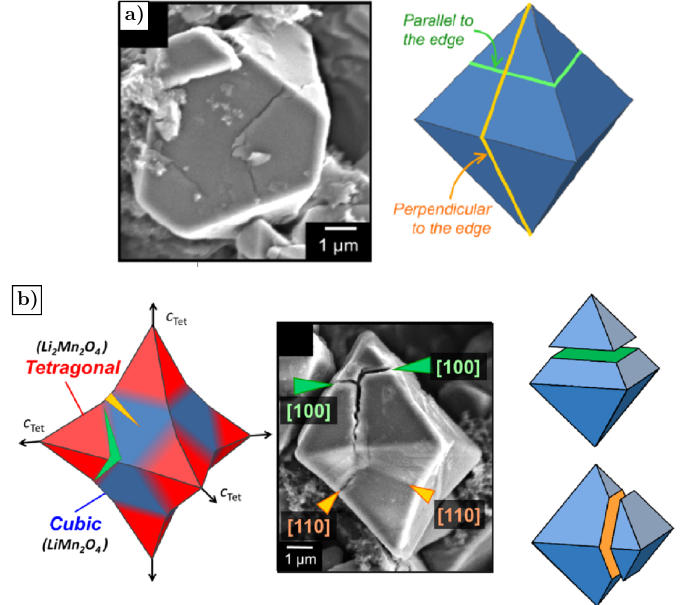
Figure 11. ( a ) Cubic and ( b ) tetragonal structure of LMO with the corresponding preferential cracks directions. Reprinted with permission by American Chemical Society from [83], Copyright 2021.